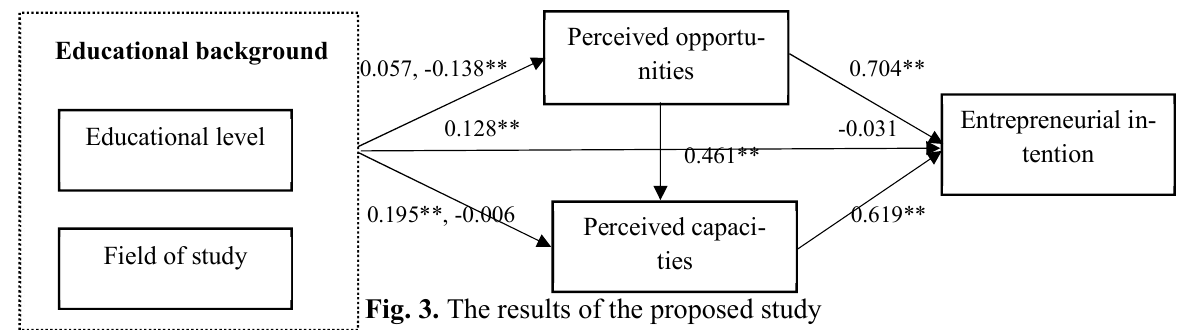
Fig. 3. The results of the proposed study